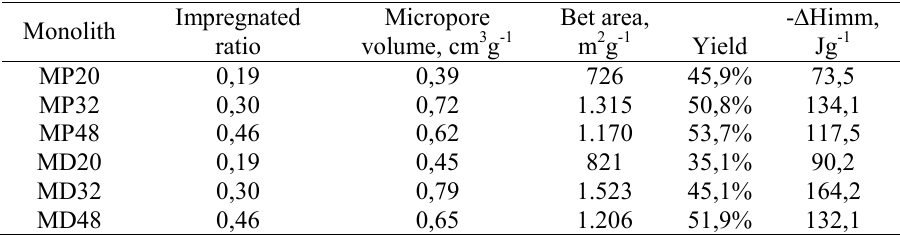
Table 1. Characteristics of activated carbon monoliths, MCA.